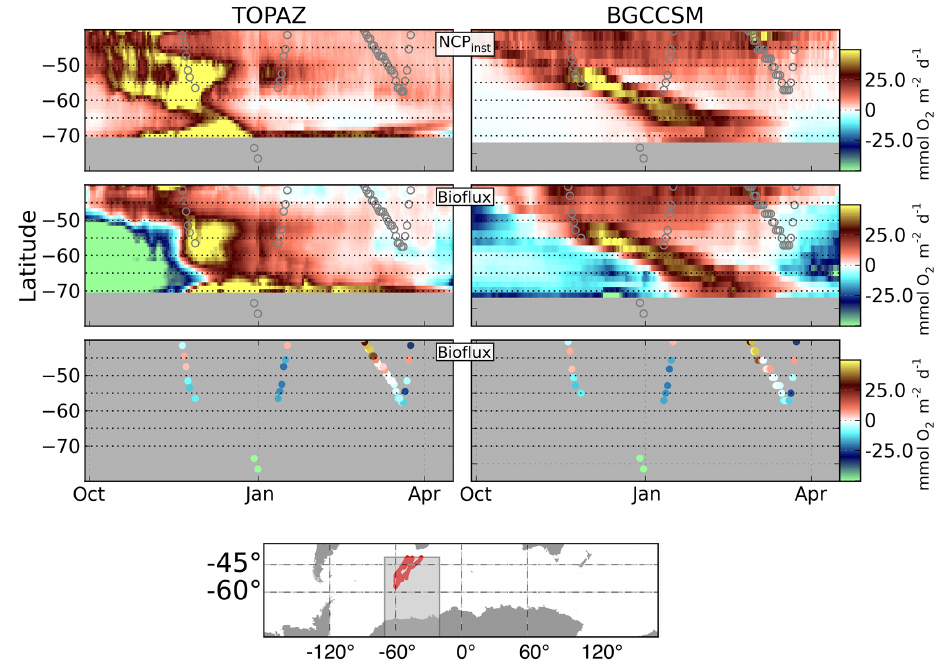
Figure 8. Hofmøller plots of model NCP (mmolm − 2 d − 1 , top panel), model O 2 bioflux (mmolm − 2 d − 1 , middle panel), and observed O 2 bioflux (mmolm − 2 d − 1 , bottom panel) in the Southern Ocean south of South Africa (locations of observations are presented as red points on the map). All model values are zonal medians within the box. All observations that fall on a specific grid cell on a specific day of the year are averaged to one